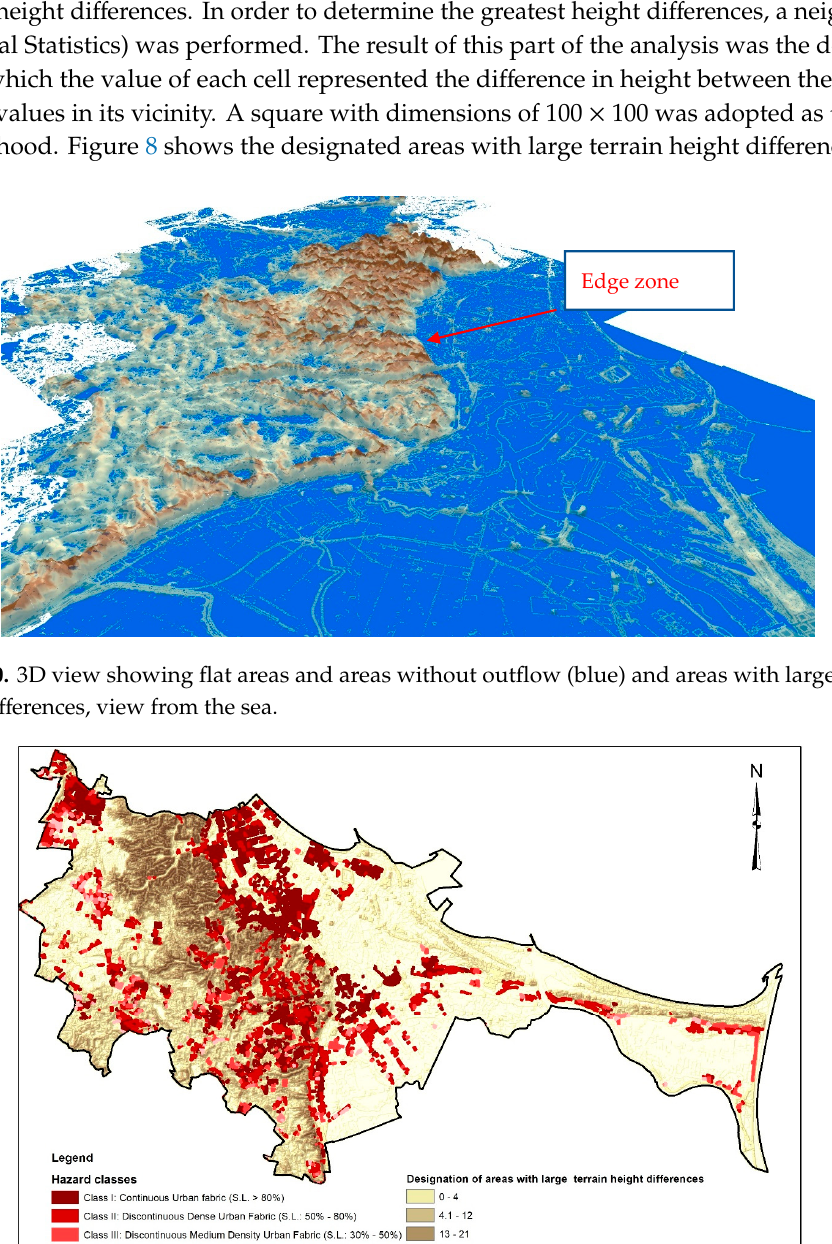
Figure 9. Overlaid results for three predictors